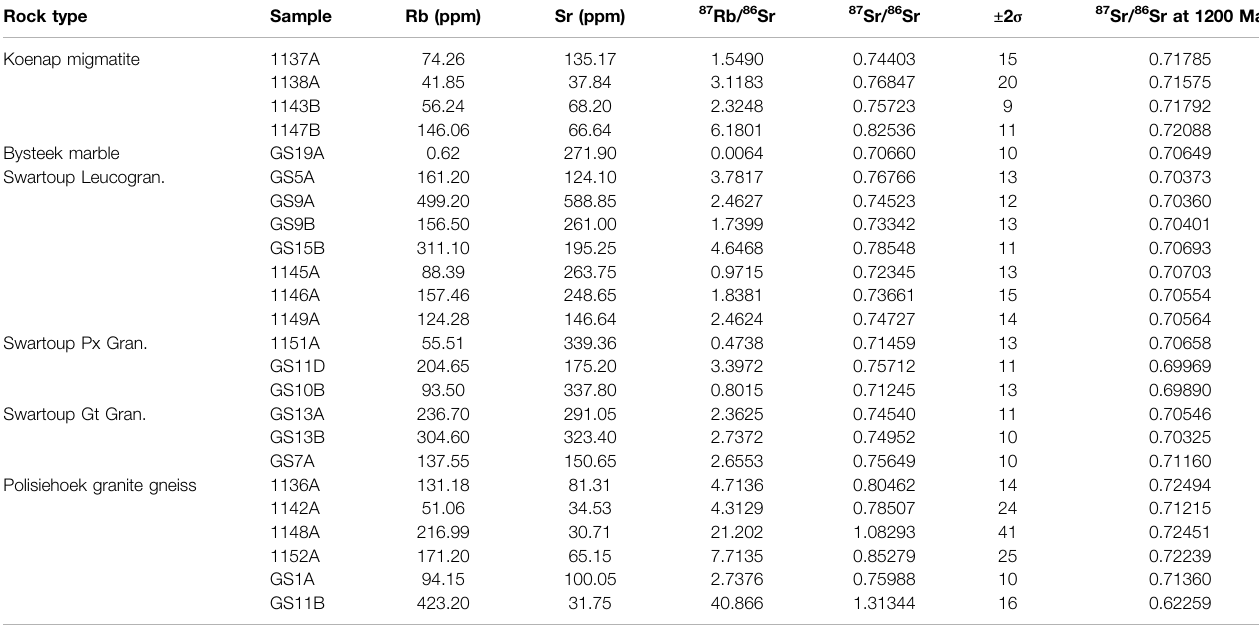
TABLE 2 | Radiogenic isotopic data for this study. (Rb – Sr isotopic compositional data). Rock type Sample Koenap migmatite